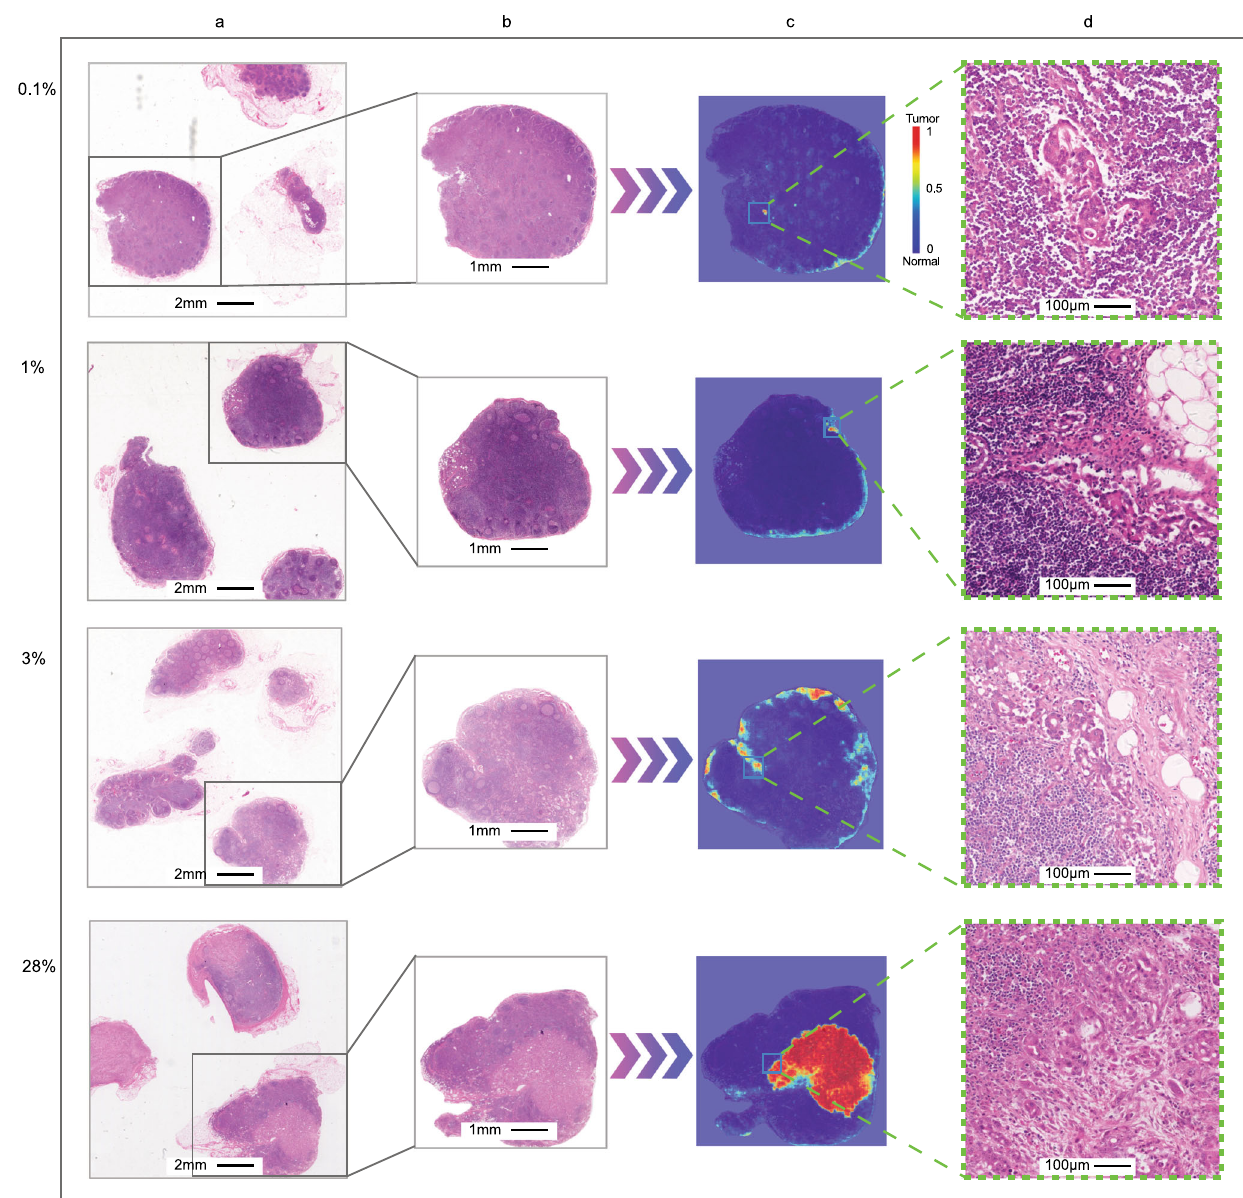
Fig. 3 Visualization of the prediction results of four slides selected from the CH Hospital 2001 – 2005 cohort. We performed the analytical work fl ow on each slide to identify the lymph node areas of the gastric cancer and generate the heatmap of the tumor areas. We selected four slides with different tumor metastasis ratios. The redder the color, the higher the con fi dence of the tumor. a WSIs of lymph node tissue, b lymph node areas of segmentation network output, c heatmaps of classi fi cation network output, and d partial magni fi cation of the detected tumor